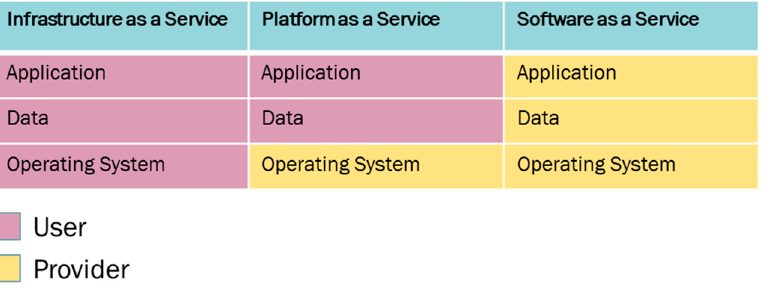
Figure 1. Abstracted layers for each service model.